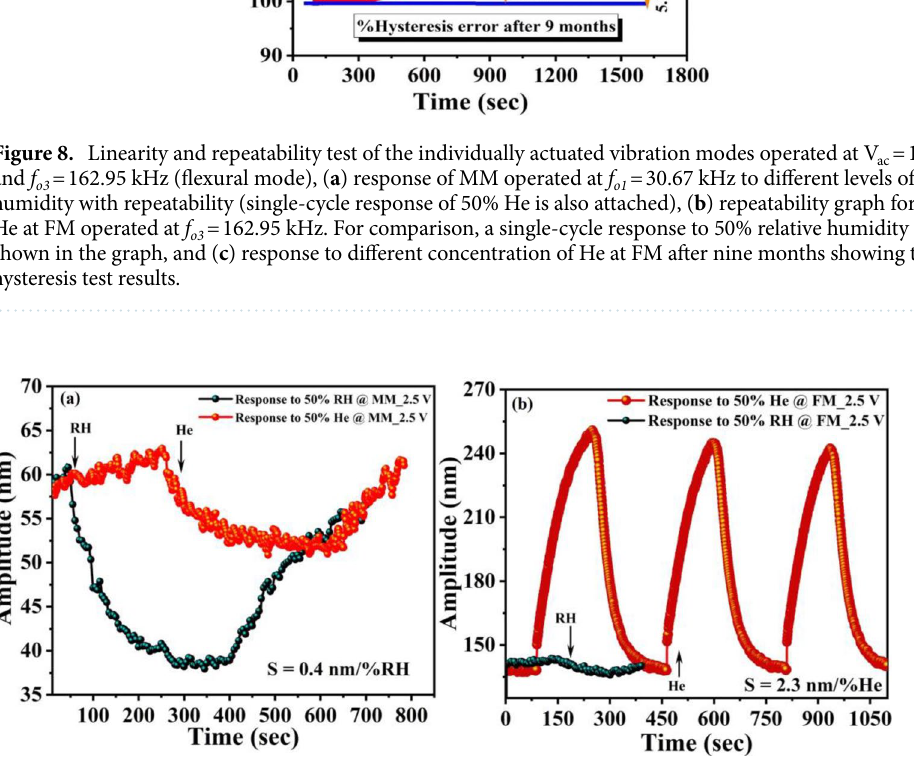
Figure 9. Response of individually actuated vibration modes when excited with V ac = 2.5 V, ( a ) response to 50% RH and 50 He% (single cycle) at MM, ( b ) response to 50% He with repeatability and 50 He% single cycle at